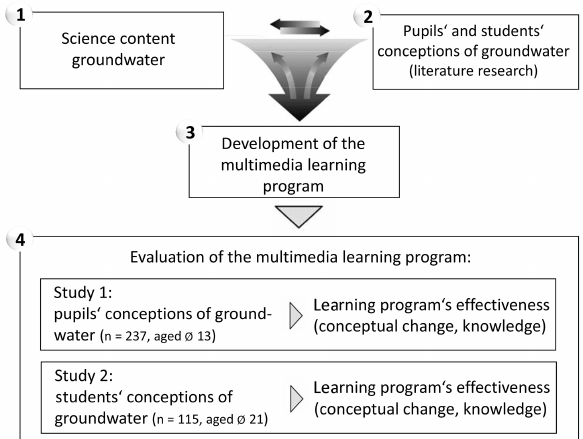
Figure 1. MER-based research